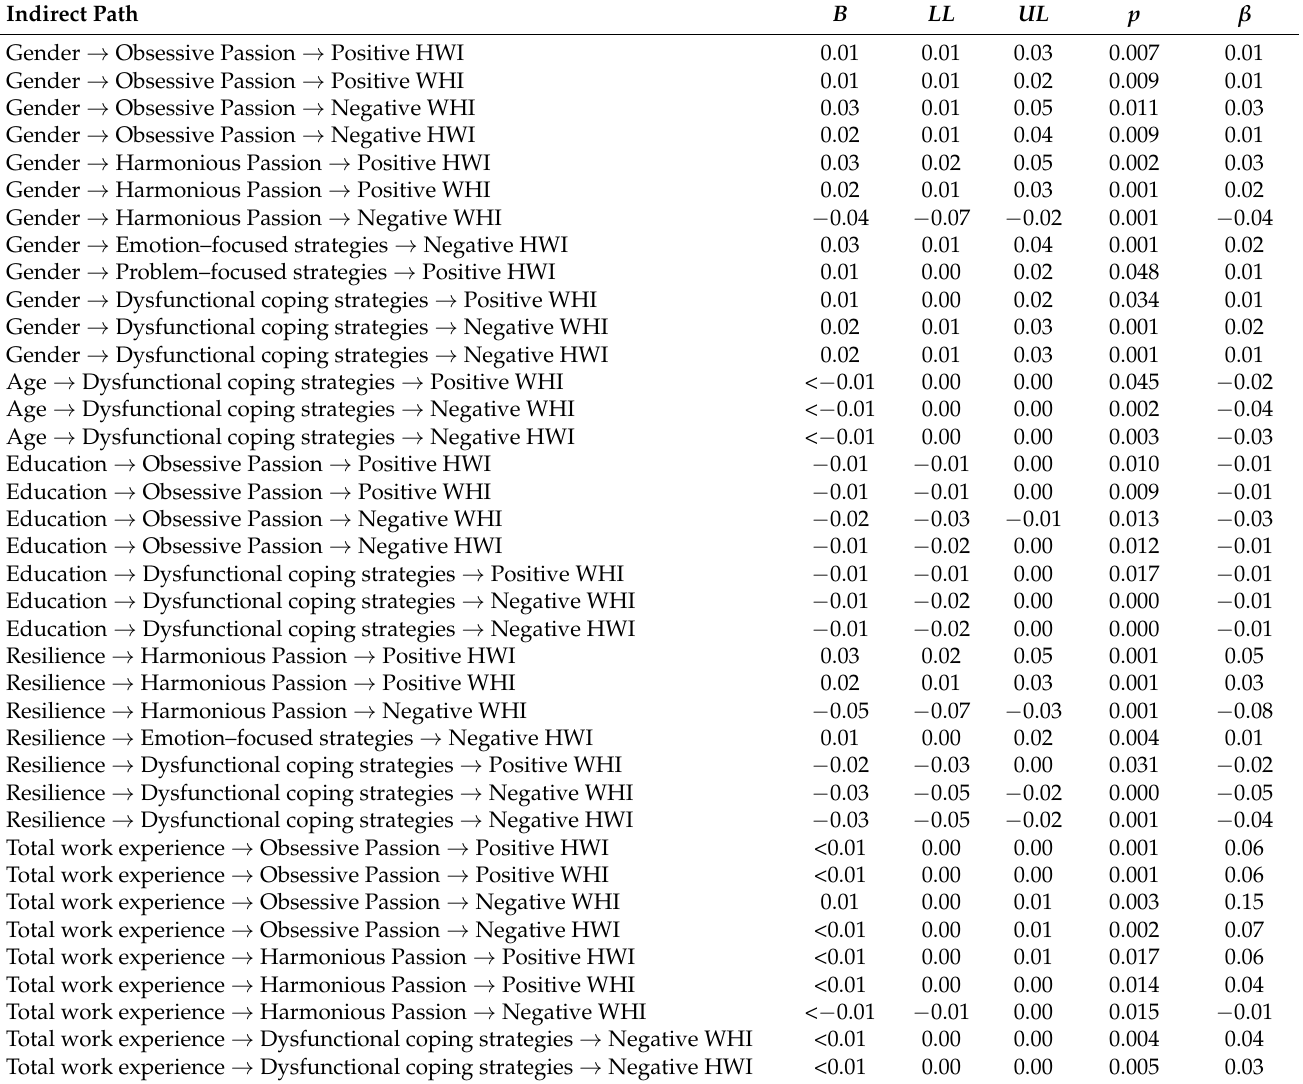
Table 7. Indirect effect coefficients for individual paths—specific